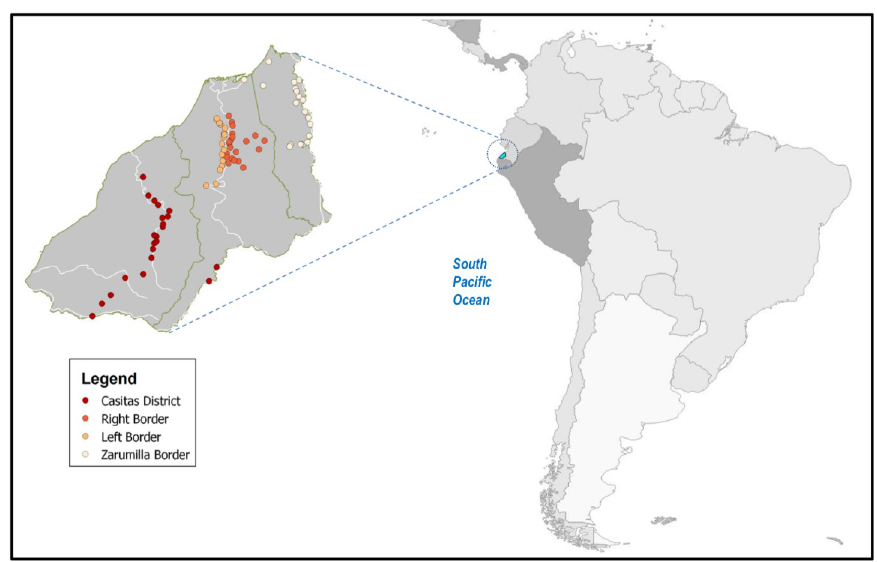
Fig 1. Map of 80 rural communities in Tumbes involved in the